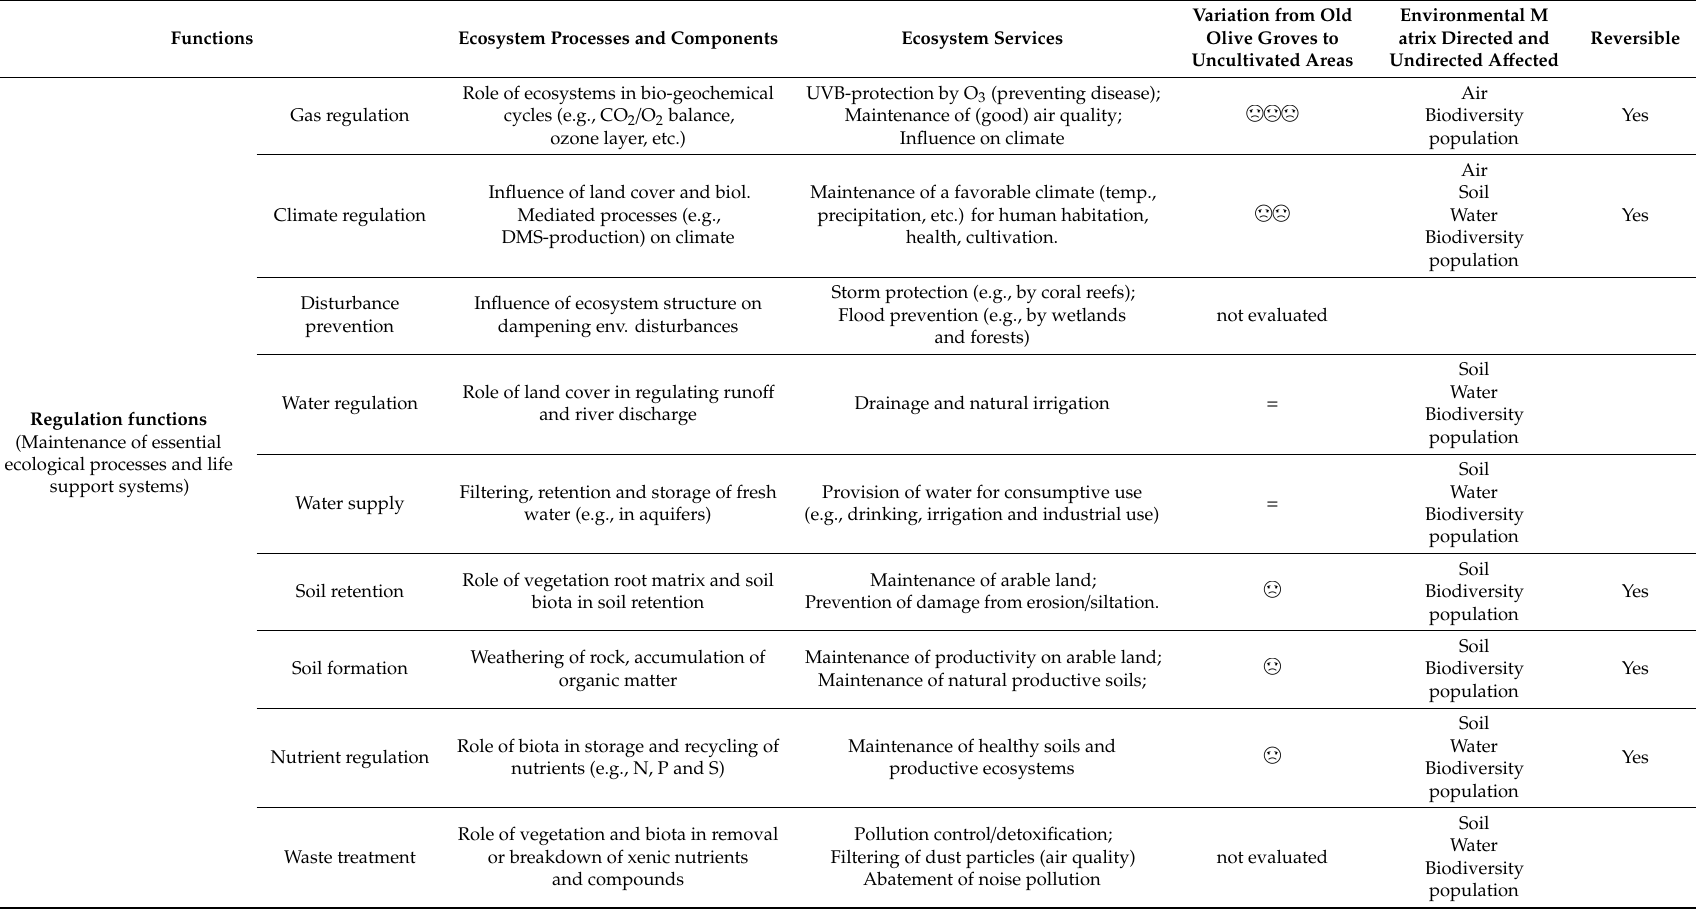
between peri-urban forests consisting of historic olive groves and the well-being of the population. Table 1. Functions, goods and services identified for natural and semi-natural ecosystems [43–47] Table 1. Functions, goods and services identified for natural and semi-natural ecosystems [43–47] integrated with the potential variation of such services connected with the change of land use from integrated with the potential variation of such services connected with the change of land use from Table 1. Functions, goods and services identified for natural and semi-natural ecosystems [43–47] integrated with the potential variation of such services connected old olive groves to uncultivated land [48–61]. The emoticon 😊 indicates positive alteration, ☹ old olive groves to uncultivated land [48–61]. The emoticon 😊 indicates positive alteration, ☹ with the change of land use from old olive groves to uncultivated land [48–61]. The emoticon indicates negative alteration, indicates negative alteration, whereas the symbol = indicates no significant alteration. The number indicates negative alteration, whereas the symbol = indicates no significant alteration. The number whereas the symbol = indicates no significant alteration. The number of emoticons gives an estimate of the intensity of the alteration: 1: low alteration; 2: medium of emoticons gives an estimate of the intensity of the alteration: 1: low alteration; 2: medium of emoticons gives an estimate of the intensity of the alteration: 1: low alteration; 2: medium alteration; 3: strong alteration; 3: strong alteration. alteration; 3: strong alteration. Variation from Ecosystem Old Olive Old Olive al M atrix Functions Processes and Ecosystem Services Groves to Ecosystem Services Groves to Directed and Components Areas Areas Role of ecosystems in Gas ☹☹☹ Biodiversity cycles (e.g., (good) air quality; CO 2 /O 2 balance, Influence on climate ozone layer, etc.)